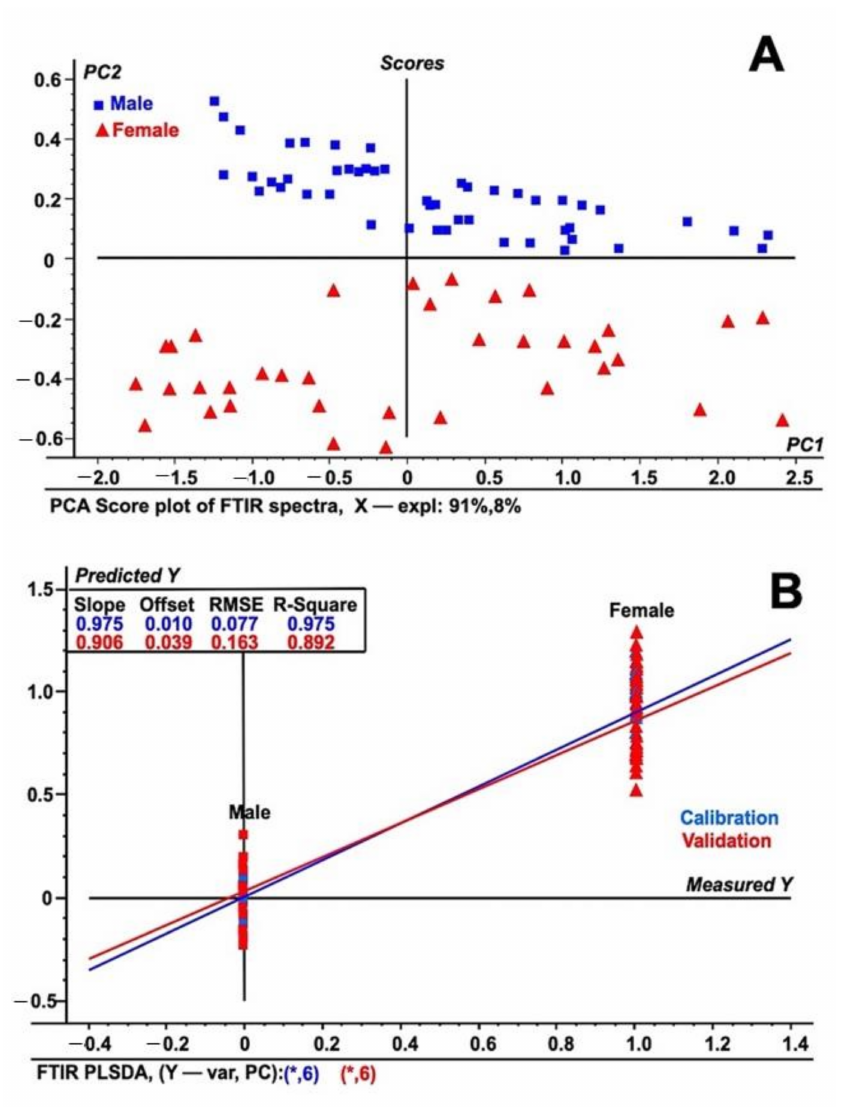
Figure 4. PLSDA analysis of immature leaf samples of Date palm ( A ) PCA score plot using FTIR ATR spectral data from male and female date palm leaves samples. ( B ) PLS-DA plot using FTIR ATR spectral data from both male and female date palm leaf samples. The figure shows both the calibration and validation of the tested samples using spectral data in the wavelength range of 400 to 4000 cm − 1 . The spectra represent the fifty individual samples each from male and female and that were tested five